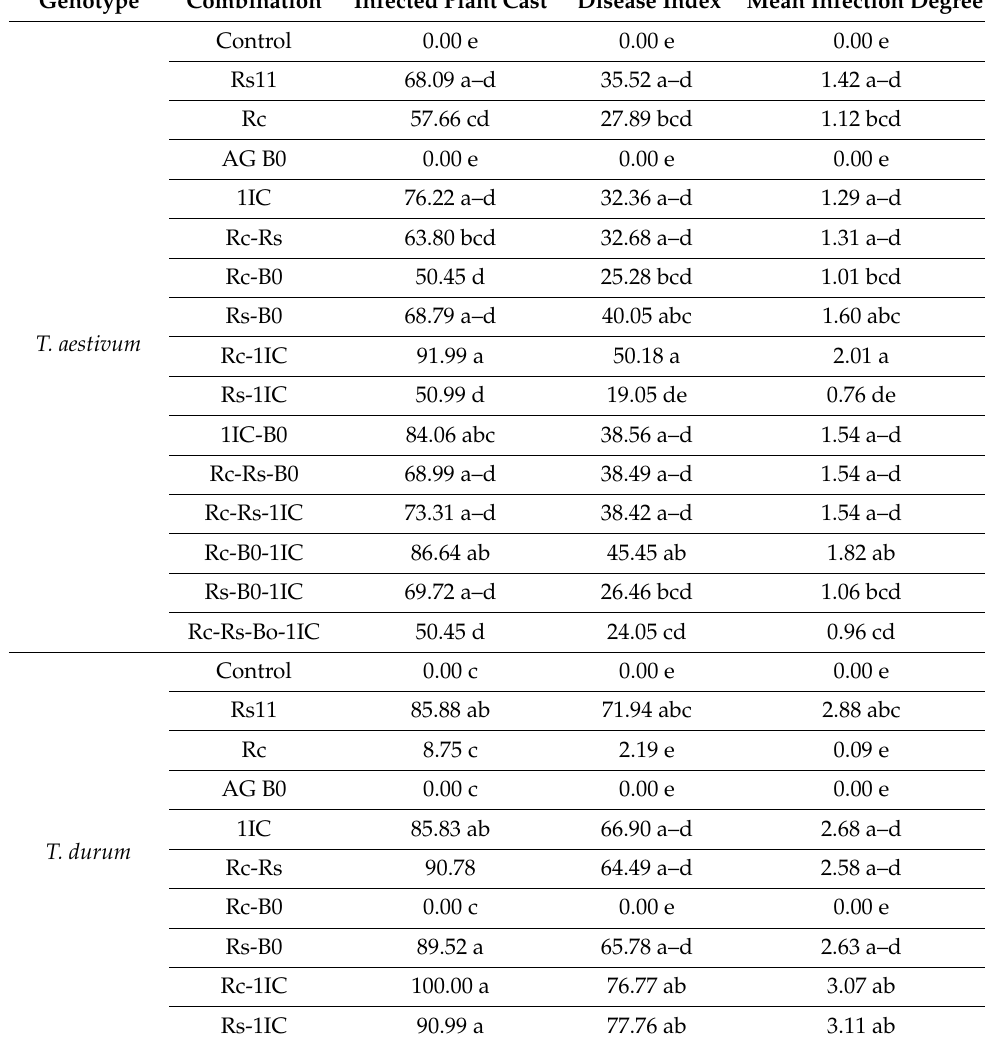
Table 2. One-way Anova results for each plant genotype in the context of disease severity parameters in experimental combinations. Different letters (a through to f) indicate a statistically different group defined by the value